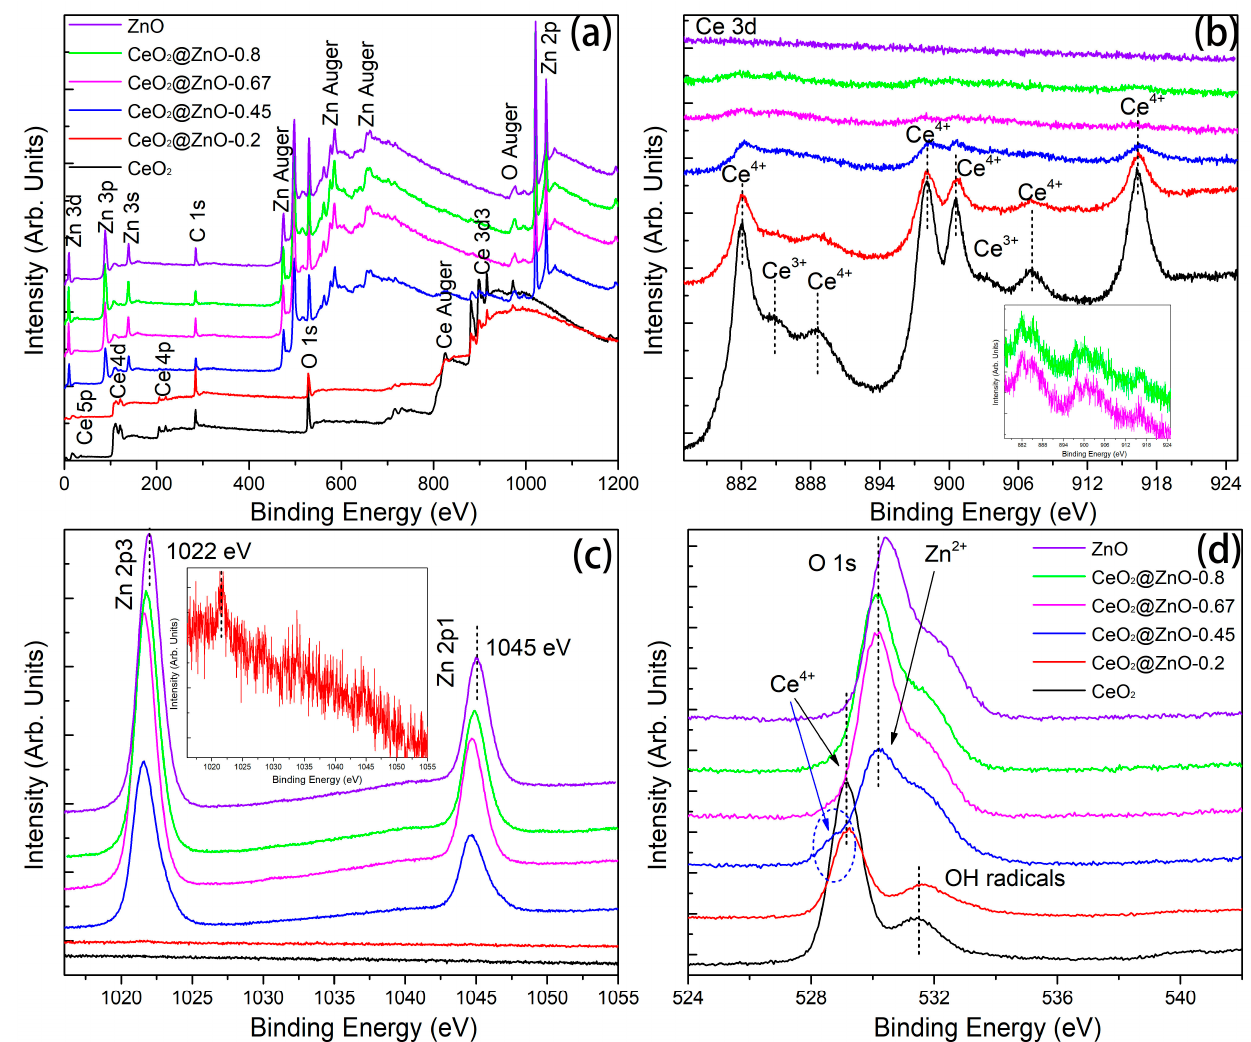
Figure 5. XPS spectra of the CeO 2 , ZnO, and CeO 2 @ZnO nanocomposites: ( a ) survey spectra and high-resolution ( b ) Ce 3d, ( c ) Zn 2p, and ( d ) O 1s spectra. high-resolution ( b ) Ce 3d, ( c ) Zn 2p, and ( d ) O 1s